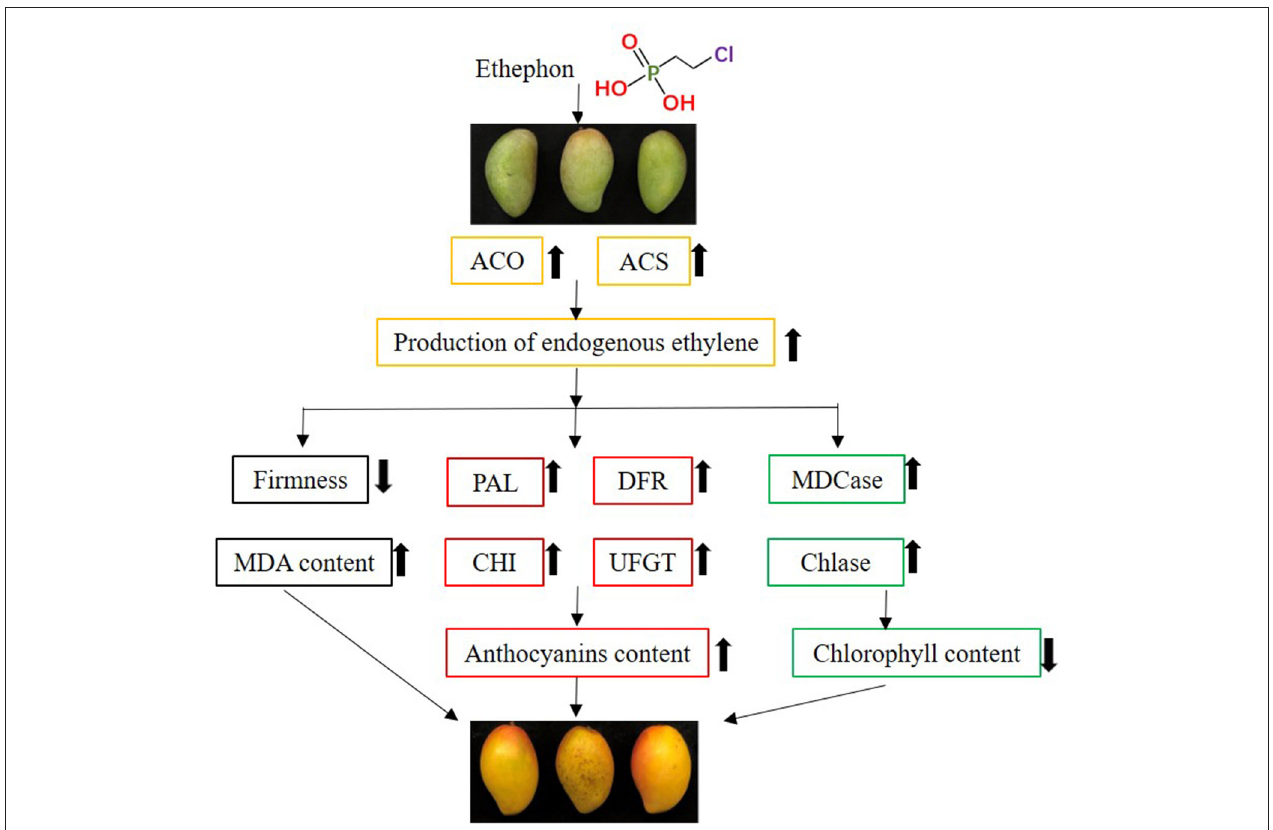
FIGURE 8 | The mode of action of ETH on mango fruit ripening and color transformation.